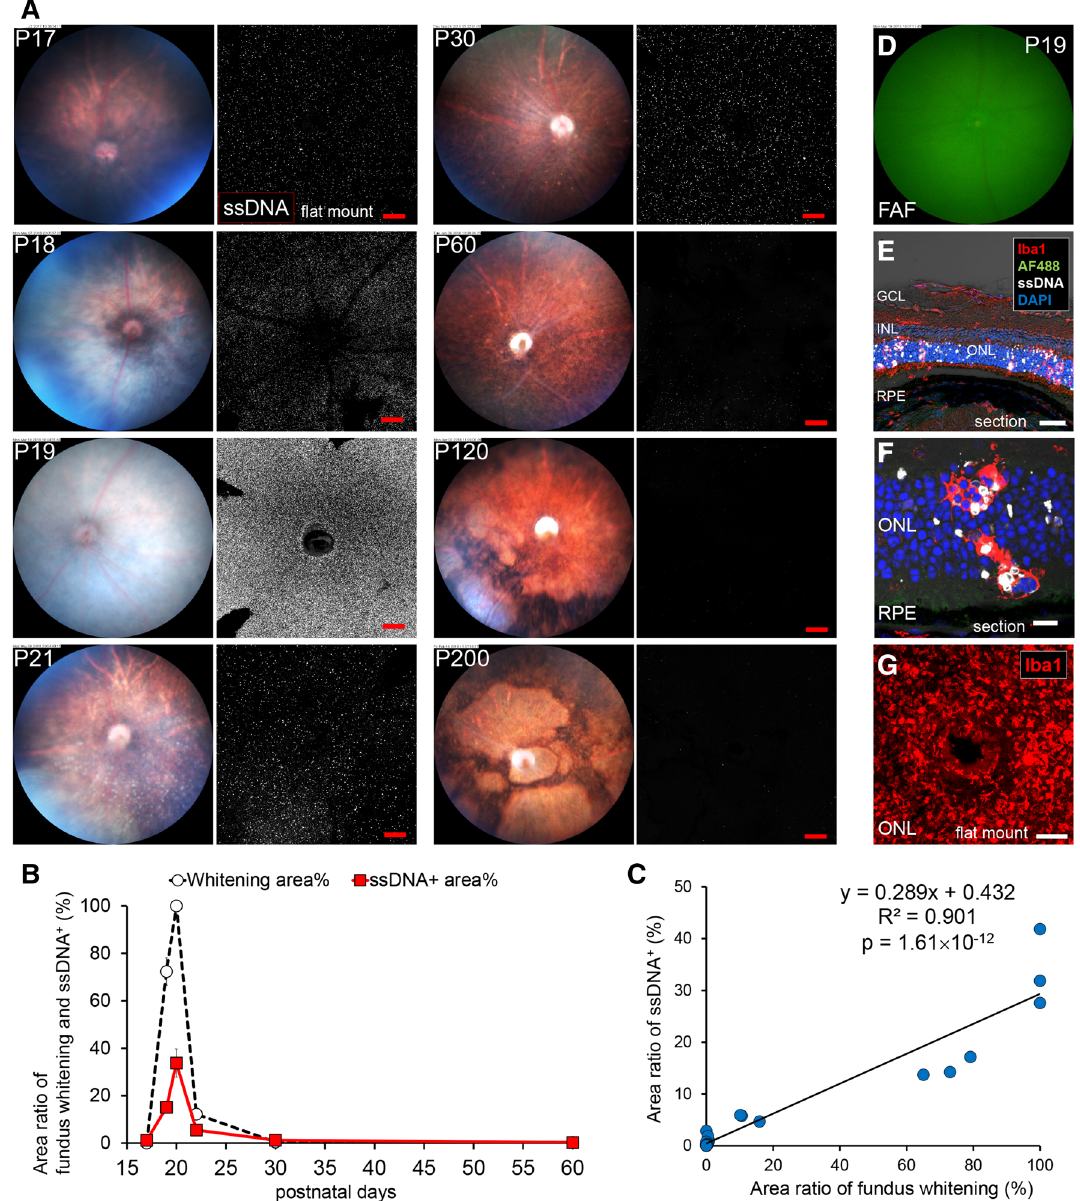
Figure 1. Relationship between fundus whitening and apoptosis of photoreceptors in the retina of rd10 mice. ( A ) Pictures show the time course change of the fundus color and apoptosis in the retina of rd10 from P17 to P200. Left pictures are in vivo fundus color photography. Right pictures show the confocal images of extracted flat-mounted retina at the ONL level, labeled with an apoptosis marker ssDNA (white). Scale bars, 100 μm. Fundus started to whiten on P19. Whitening spread throughout the whole surface on P20. On P22, white granular spots on the subretina were observed. Around P30–P60, the color tone of the retina became normal. Remarkable retinal atrophy was observed after P120. ( B ) Graphs show time course of fundus whitening area (%) (White marker) and ssDNA + area (%) (Red marker). The markers of the graph show mean and standard deviation (SD) (n = 3). Peaks of both parameters coincide. ( C ) Scatter plot shows the relationship between the ssDNA + area (%) and the whitening area (%). Measurement points were P17, 18, 19, 21, 30, 60, 120 and 200, n = 3 respectively. A linear relationship was found between both factors (R 2 = 0.901). ( D ) There were no autofluorescent spots in FAF imaging of the central retina. ( E , F , G ) Pictures show the histopathological findings on fundus whitening at P19. ( E ) Flat-mounted retina labeled with Iba1, ssDNA and DAPI. SsDNA + apoptotic photoreceptors in the ONL and infiltration of Iba1 + microglia from the ONL to the OS were observed. Scale bar, 40 μm. AF488, autofluorescence excited by 488 nm light; GCL, ganglion cell layer; INL, inner nuclear layer; RPE, retinal pigment epithelium. ( F ) Magnified image of the retinal section at the ONL. Microglia infiltrated from the ONL to the OS and phagocytized both apoptotic and non-apoptotic photoreceptors. Scale bar, 10 μm. ( G ) Retinal flat mount of rd10 (P22) at the depth of the OS, labeled with Iba1. Iba1 + microglia accumulated in the OS at a high density. Scale bar, 100